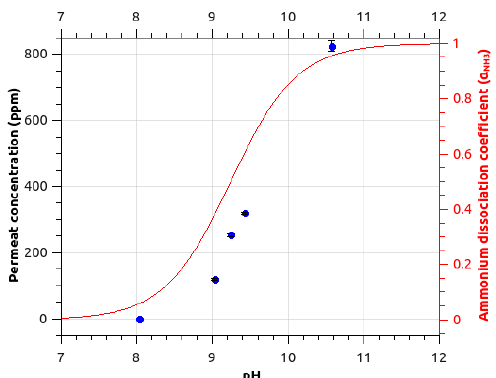
Figure 2. Ammonia signal ( m / z 18.034) measured (blue points) for different pH around the pKa. The theoretical ratio of NH 3 is superimposed as a red line (calculated for a pKa of 9.24) on the right scale. 2.2. Monochloramine Permeation Protonated monochloramine presents two peaks at m / z 51.995 and m / z 53.992 due to the isotopic